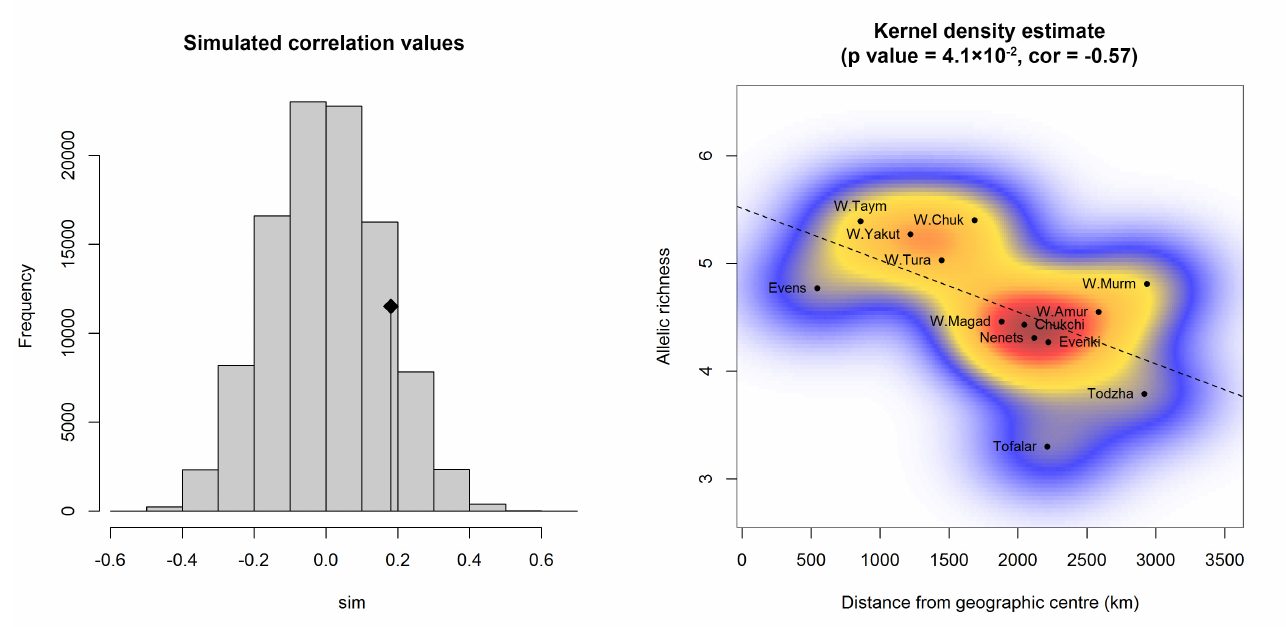
Figure 5. a) Histogram of simulated values. Results of Mantel test of correlations between genetic differentiation (Slatkin’s linearized Fst ) and geographic distance (spatial Euclidean). The black dot represents the original value of the correlation between genetic distances, measured as pairwise Fst /(1 − Fst ), and geographic (Euclid) distances. b) Distribution density of population samples plotted using a bivariate kernel density estimate. The linear regression trend is shown with a dashed line; colours represent degrees of density (blue: low; yellow: medium; red: high